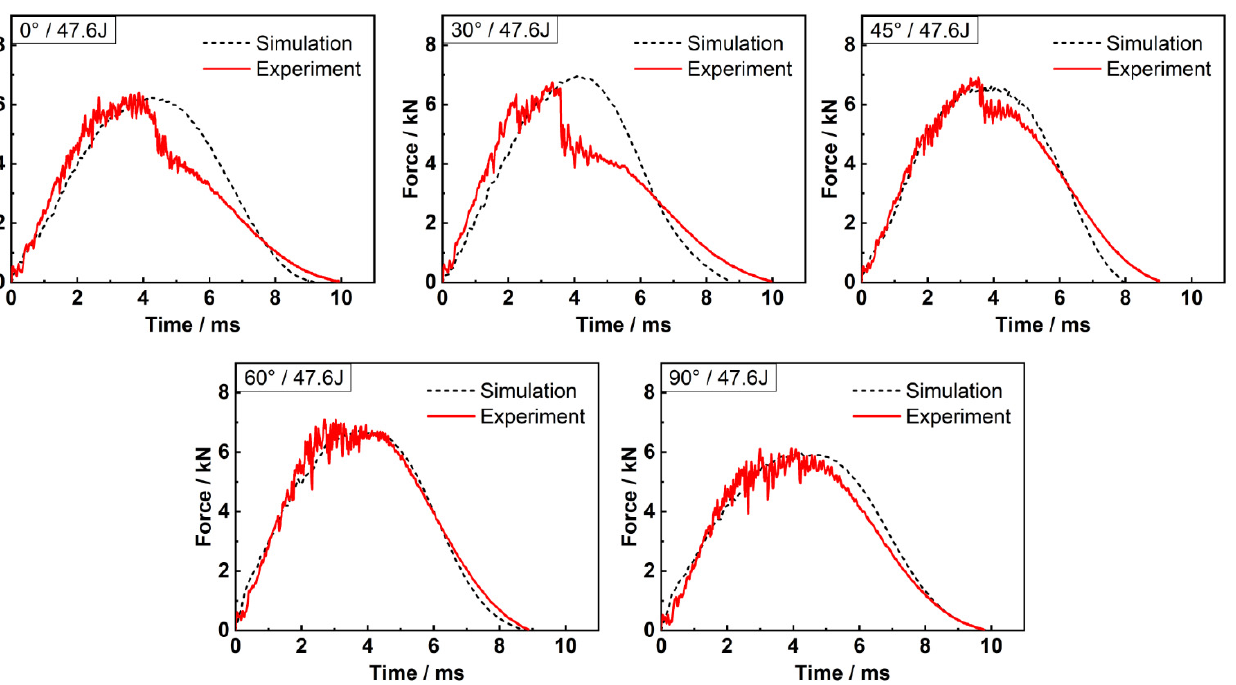
Figure 2 . Force-time relations under 21.6 J of impact energy.